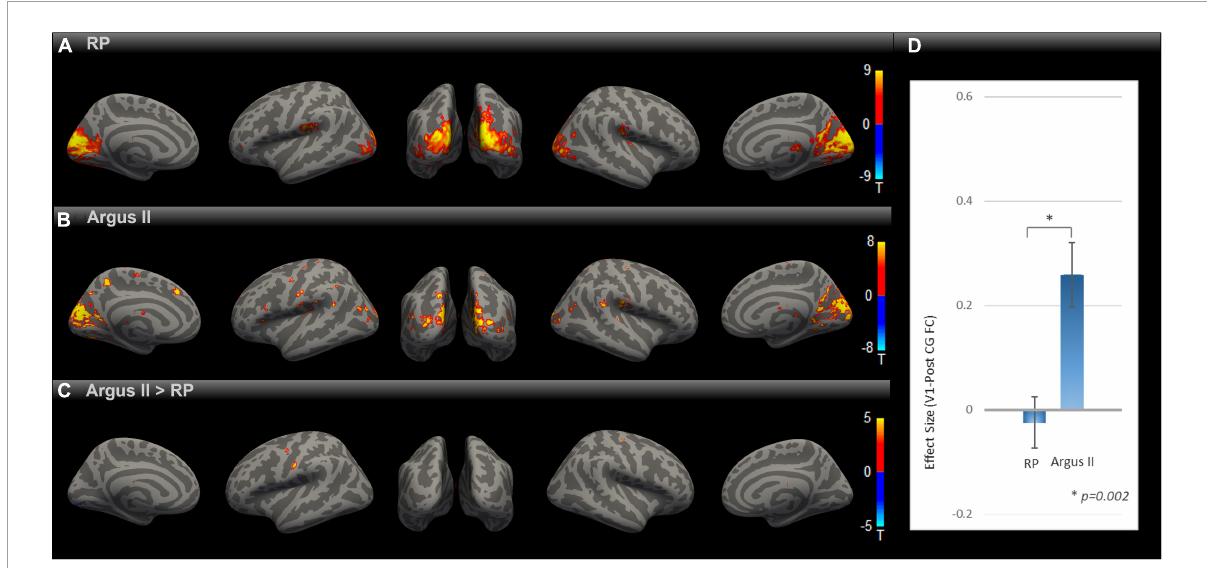
FIGURE2 Comparing rsFC between Argus and RP. Whole-brain rsFC map using V1 as the seed is calculated at the group level for RP (A) Argus II (B) and contrast Argus II > RP (C) . rsFC maps were corrected for multiple comparisons using the Gaussian Random Field Theory with an uncorrected voxel-level threshold of p < 0.001 and a cluster-level threshold of p < 0.05 FDR corrected for cluster size. Areas with higher rsFC in Argus II than RP involved pre- and PostCG regions. The ROI-to-ROI rsFC analysis between V1 and PostCG (D) additionally showed significant [ t (15) = 3.62, * p = 0.002] enhancement of this connectivity in Argus II compared with RP.